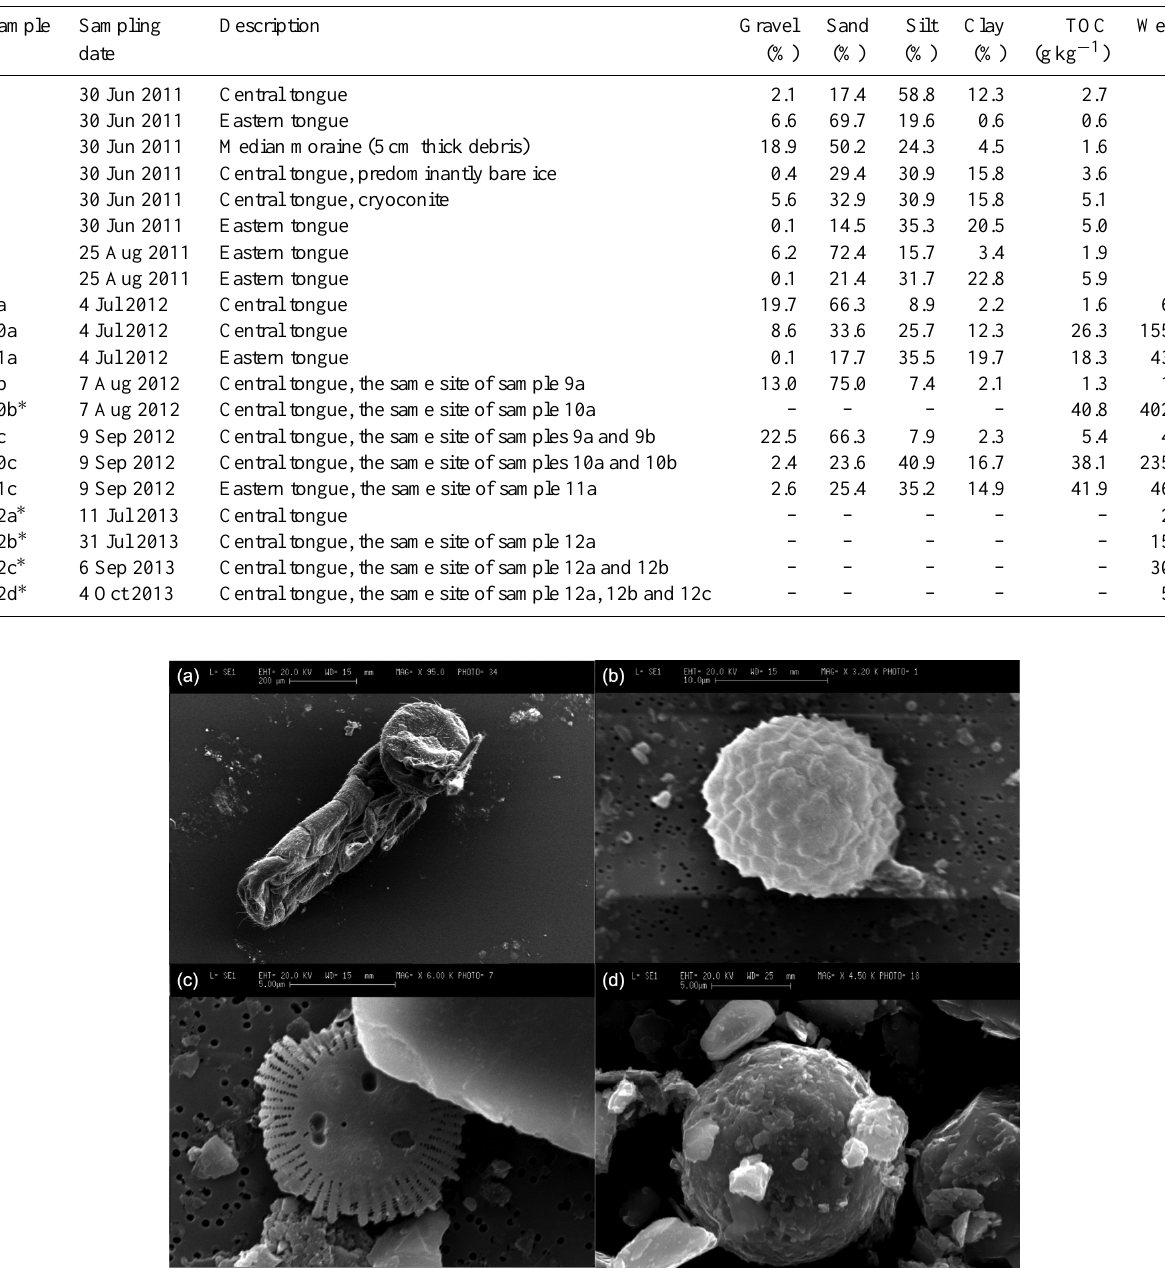
Table 2. Properties of sites sampled for sedimentological analyses and results. The grain-size classes refer to Krumbein’s scale (Wentworth, 1922). An asterisk indicates a debris sample insufficient for grain-size analysis.